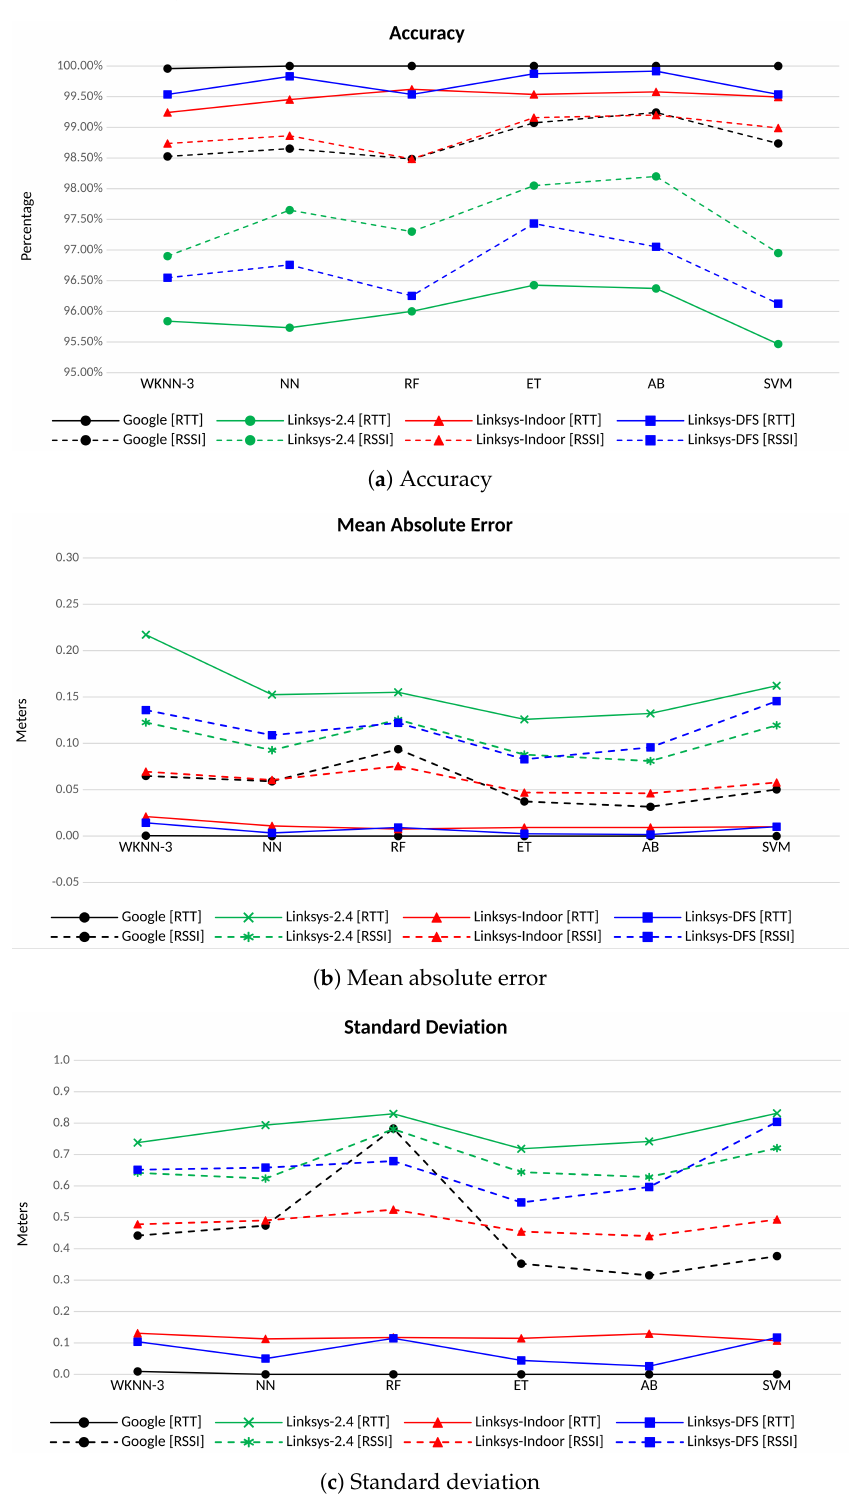
Table 4), the classification accuracy, when the Linksys APs in the 2.4 GHz band (in green) is used, is still higher than 95%.